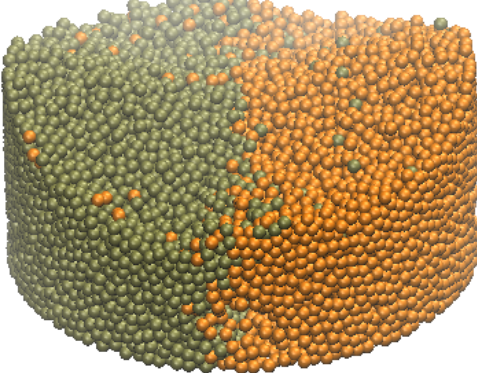
Figure 8. Initial state of mixing